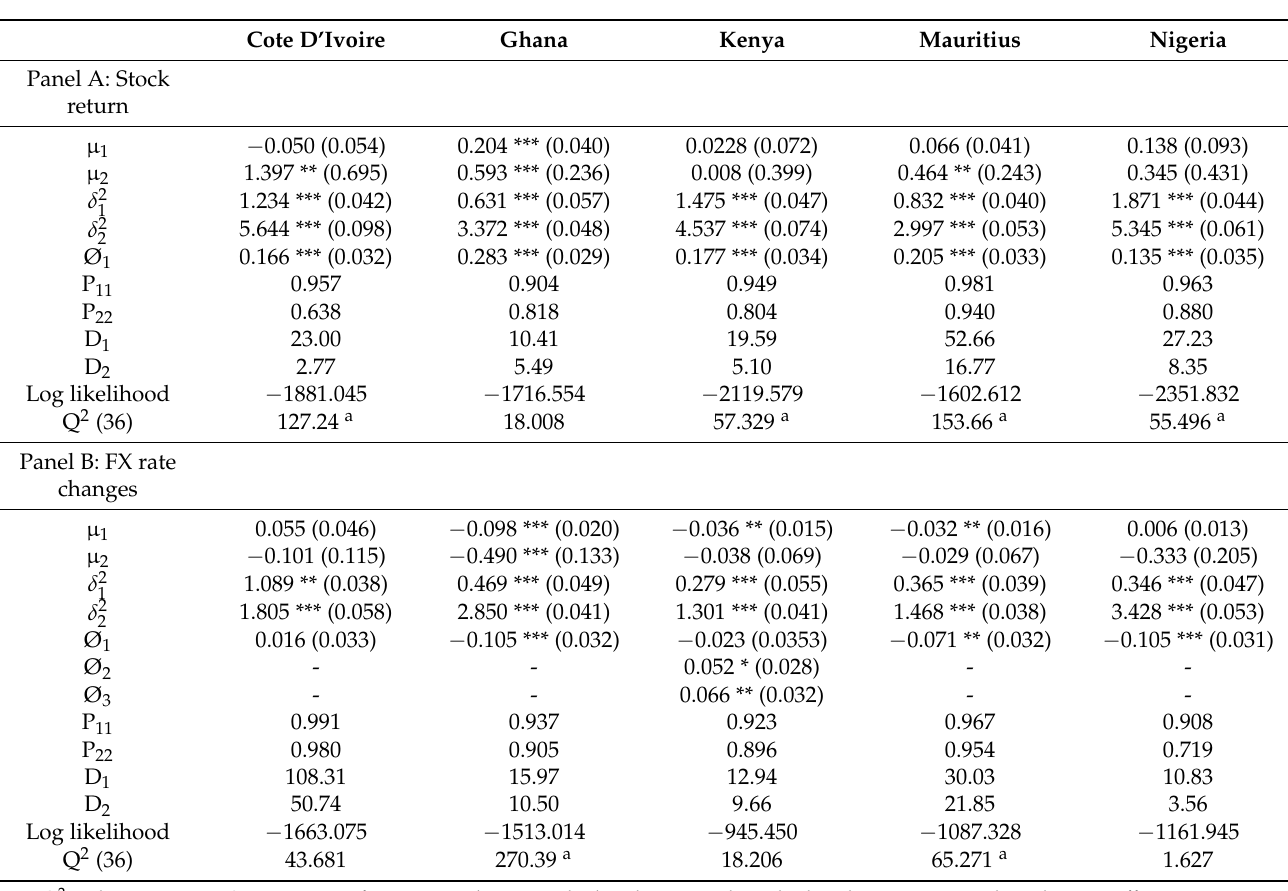
Table 8. MS-AR model